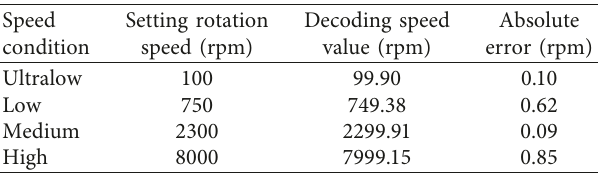
Figure 6: Process data of PFCST-based RDC: (a) original signals; (b) PFCST results of signals in (a); (c) quadrant recognition result; (d) rotation angle of the resolver calculated by the proposed method. Table 2: The maximum error of speed decoding under various